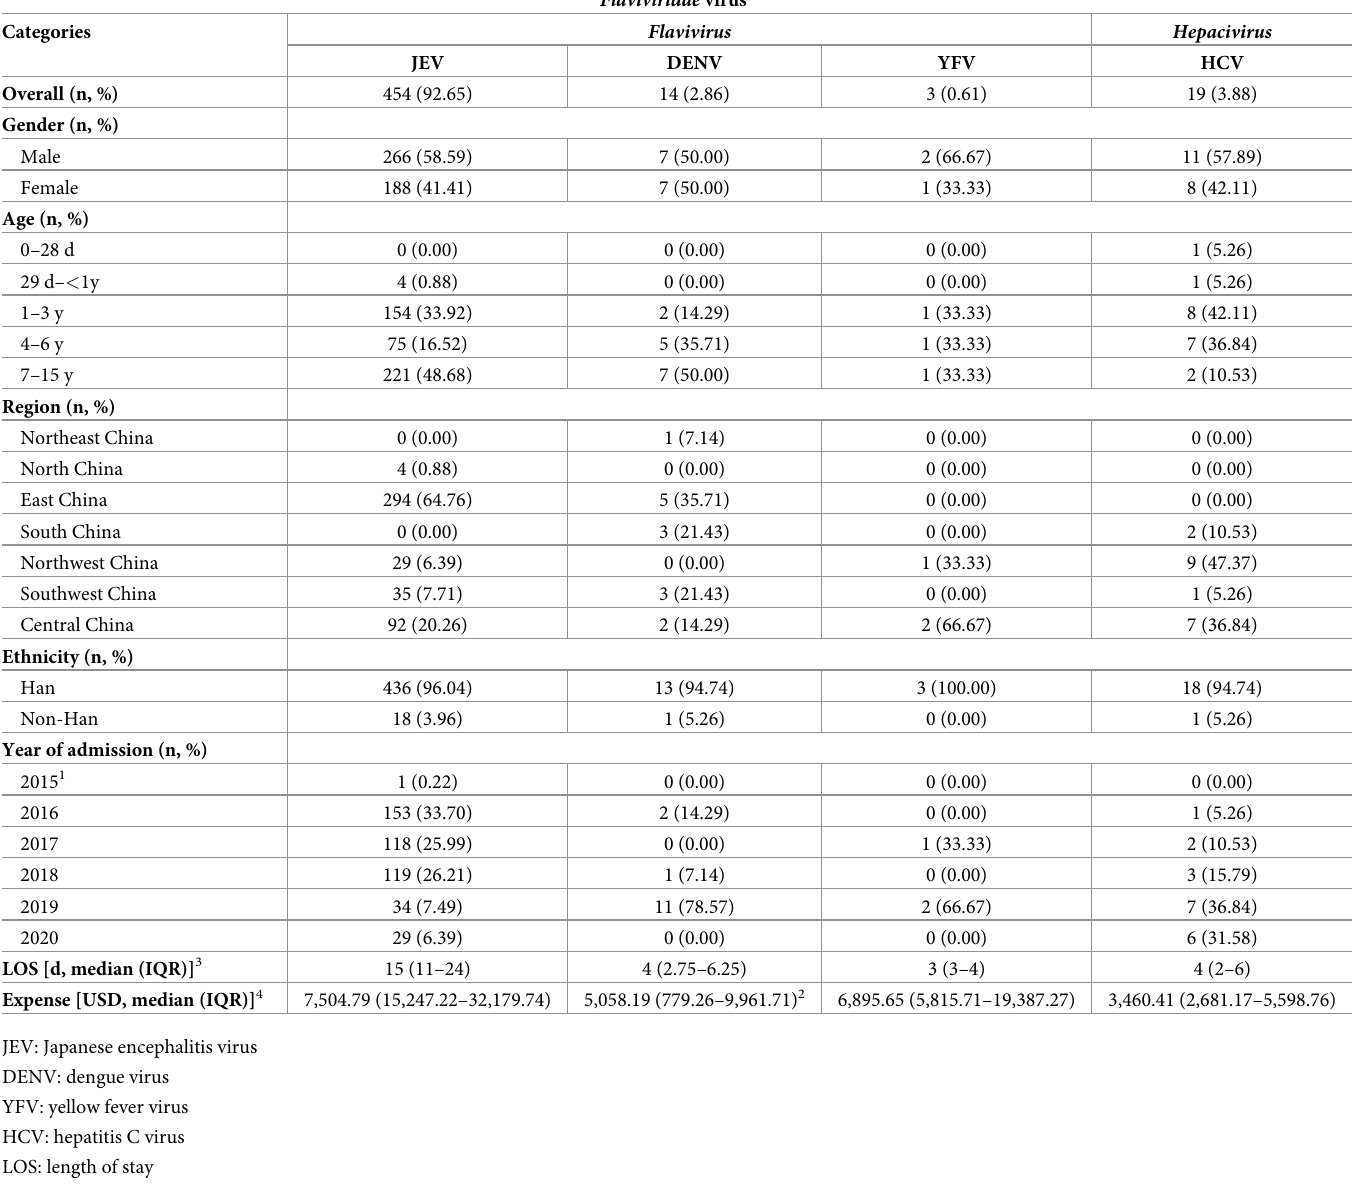
Table 2. The general sociodemographic characteristics of Flaviviridae virus infections during pediatric hospitalizations from December 2015 to December 2020. Flaviviridae